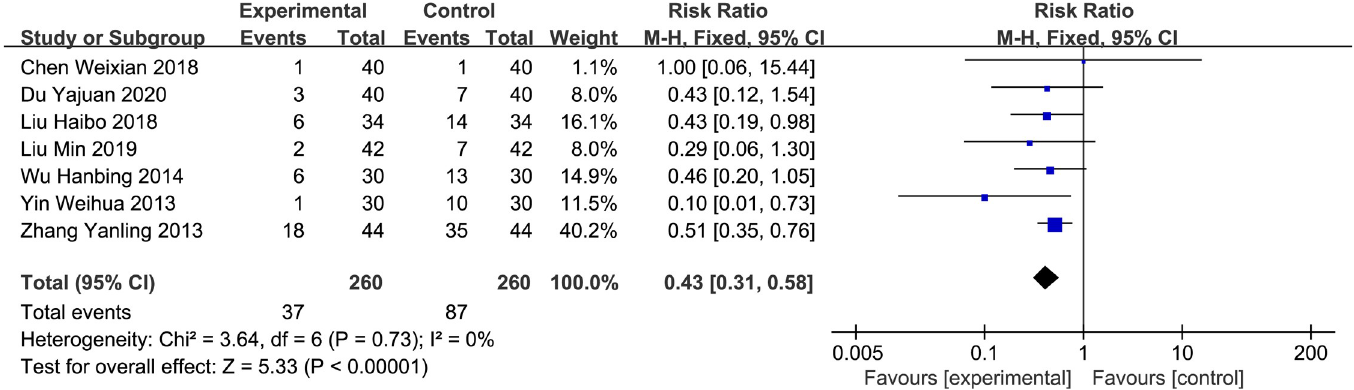
Fig 6. Forest plot of the incidence of constipation between experimental and control group.